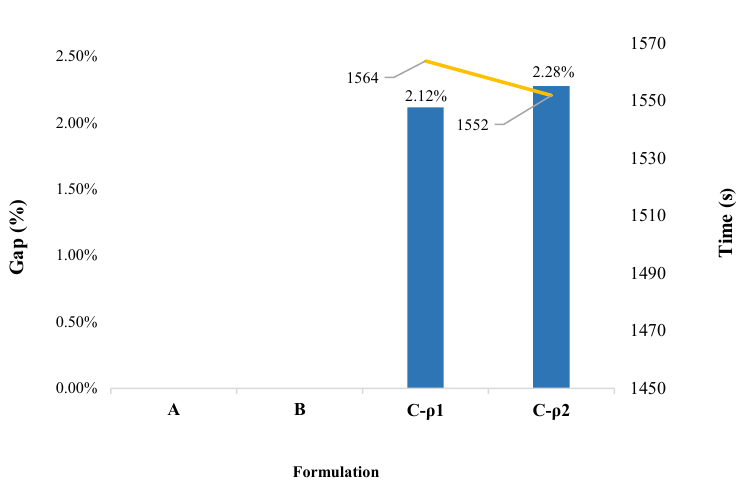
Figure 3. Optimality gap (%) vs. running time (s) for the different formulations on the desktop